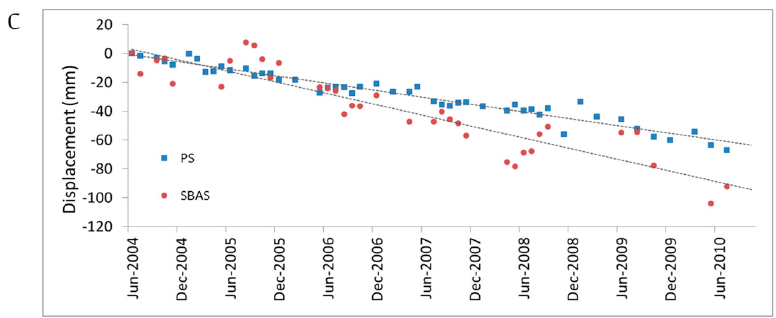
Figure 14. Comparison between the Envisat ascending ( A ) GPOD-SBAS results and the ( B ) PSInSAR results (from the Portale Cartografico Nazionale) over the Valtourenenche Valley corresponding to the Mont Meabè rock glacier; ( C ) time series corresponding to the SBAS target and the PS, signified respectively by the black square in ( A ) and by the red square in ( B ), within the Mont Meabè RG phenomenon.